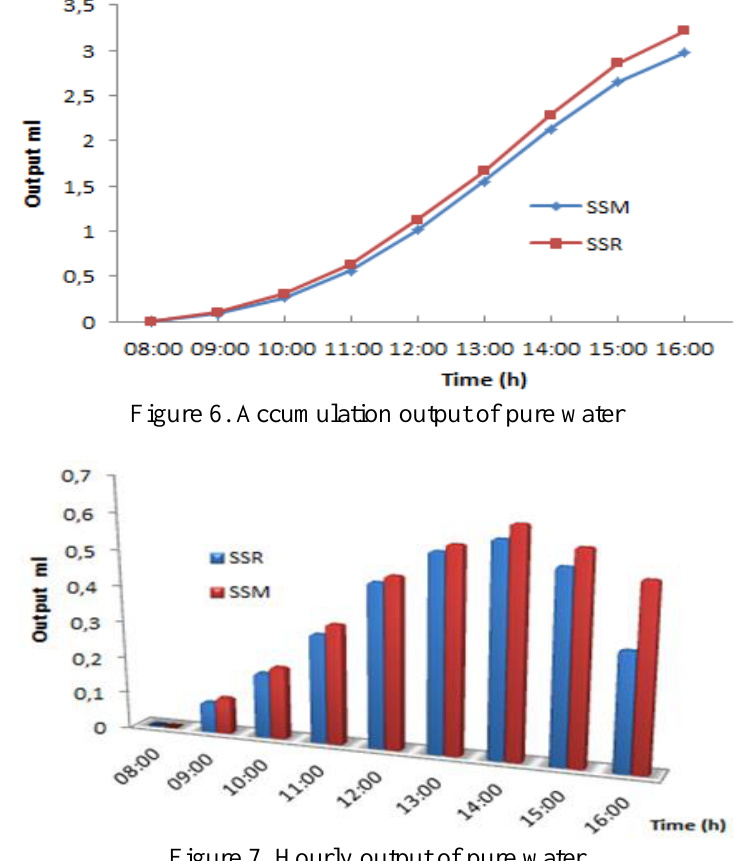
Figure 7. Hourly output of pure